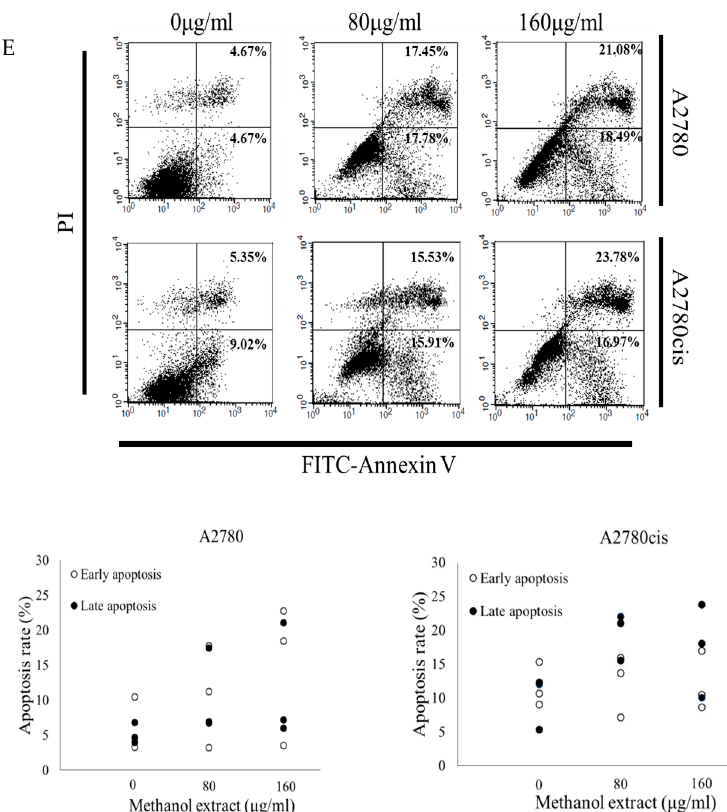
Figure 2. MOD affects ovarian cancer cell viability to a greater extent than individual bioactive compounds. Effects of bioactive compounds of OD on A2780 and A2780cis cells: ( A ) Ursolic acid (UA), ( B ) oleanolic acid (OA), and ( C ) UA and OA in combination. ( D ) Cisplatin-sensitive cell lines (CAOV3, TOV-112D) and -resistant cell lines (SKOV3, OVCAR3) were treated with methanol extract of OD (MOD). Cell viability was measured with an MTT assay after 48-h treatment. Each value uses the non-treated group as 100%. Oneway ANOVA analysis, followed by Duncan post-hoc test, was used for the comparison between treatment doses in each cell line. Different letters indicate significant difference inside a group ( p < 0.05). ( E ) Apoptosis was inducted after a 48-h MOD treatment at various concentrations (0, 80, and 160 μ g/mL) in both A2780 and A2780cis cells, stained using fluorescein isothiocyanate (FITC)-conjugated annexin-V and propidium iodide (PI), and subjected to flow cytometric analysis. Representative results are shown. In the bottom panels, the left panel is the result from A2780 cells, the right panel is that from A2780cis cells. Different letters indicate significant difference inside a group as determined by Student’s t-test for A2780 (capital letters) and A2780cis (small letters) results.